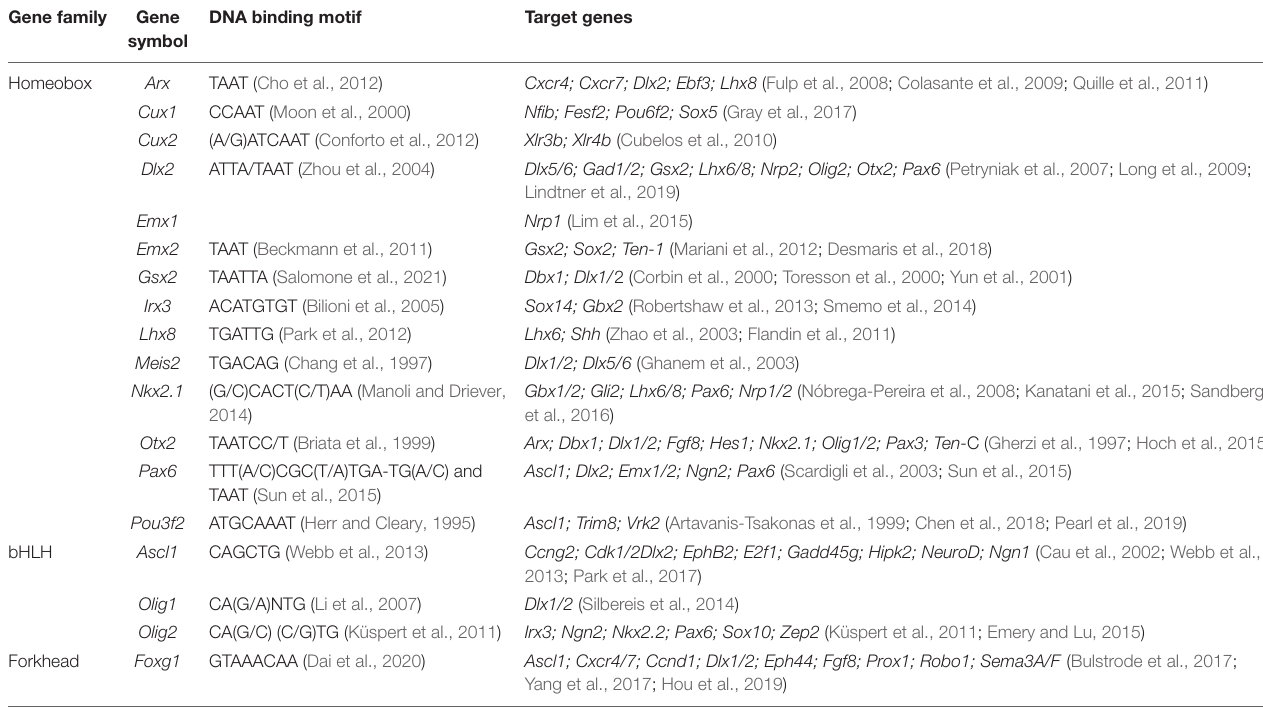
TABLE 2 | DNA binding motifs and selected target genes. Gene family Gene DNA binding motif Target symbol